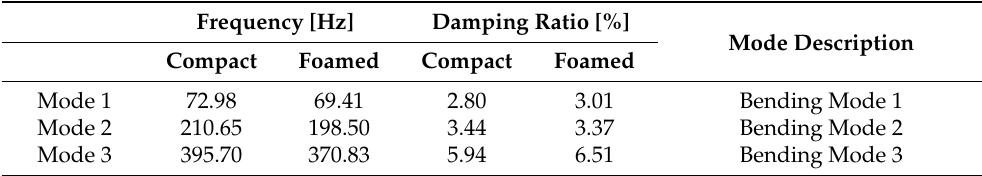
Table 7. Estimated natural frequencies, mode descriptions, and damping ratios of tested composite beams. All bending modes are along the y-axis.